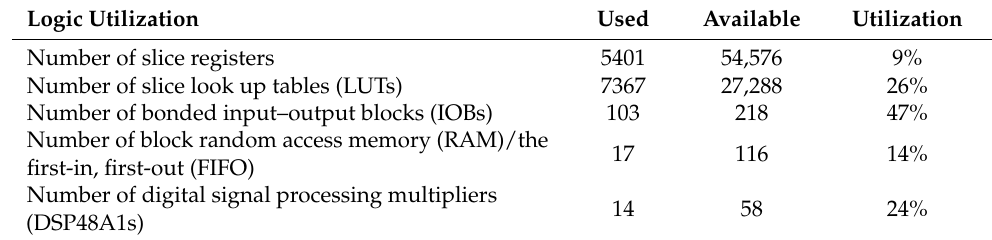
Table 3. Hardware resources of the Spartan 6 XC6SLX45 FPGA used by the SMFFD system.